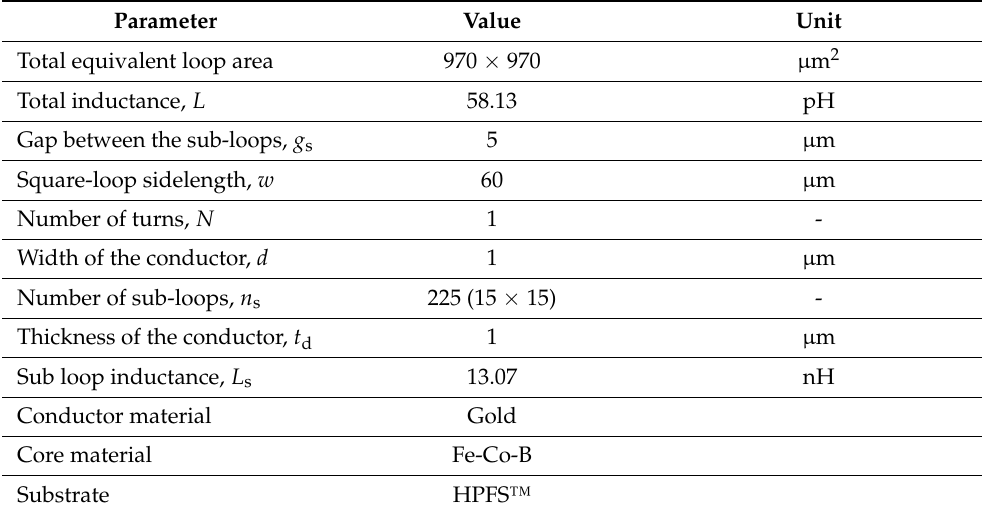
Table 2. Sensor inductor